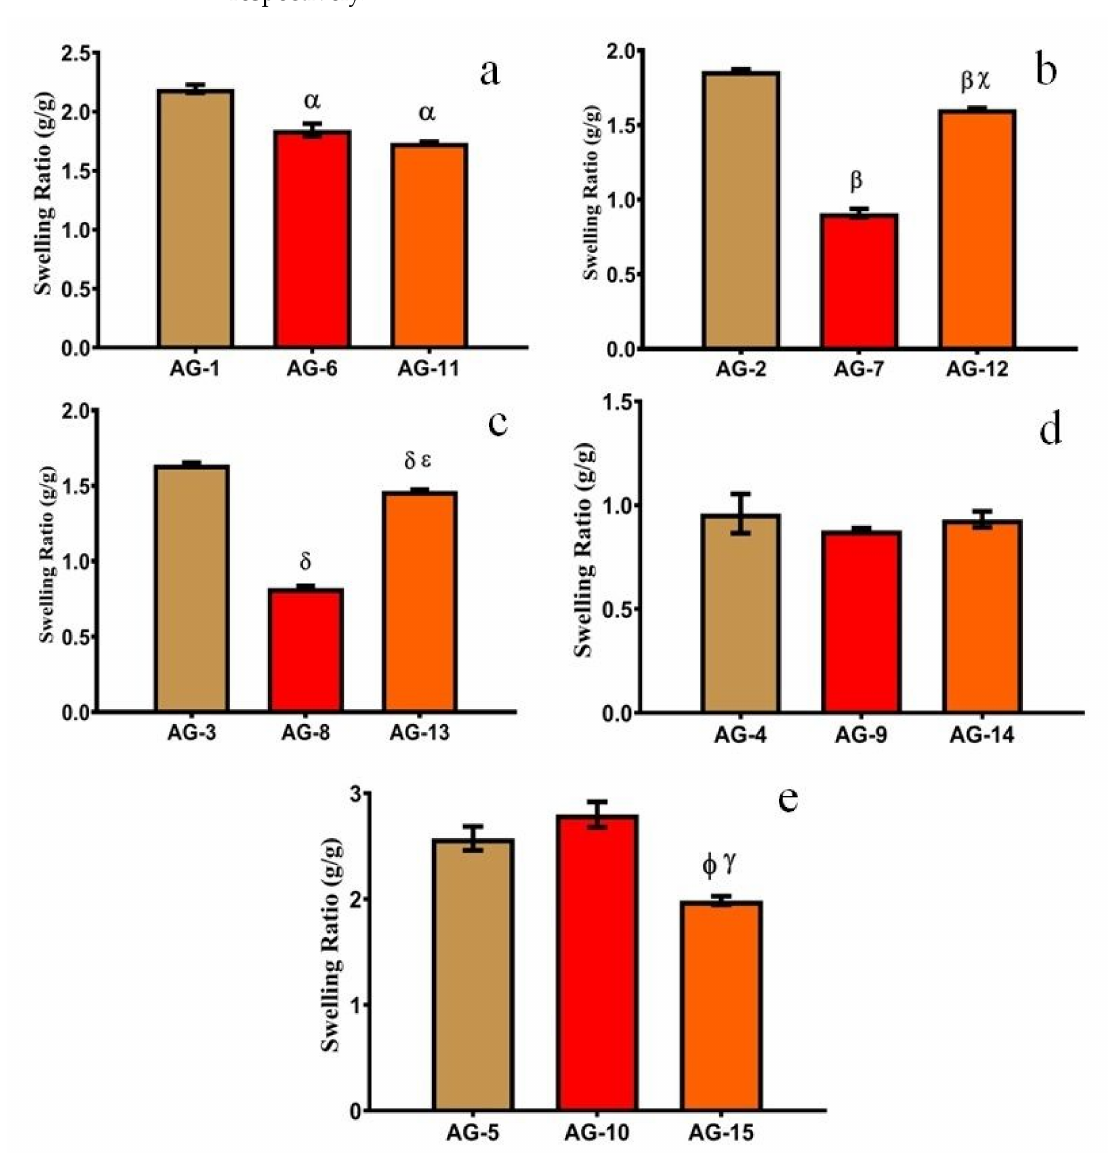
Figure 4. Effect of gelatin on equilibrium SR at pH 1.2 with different AA concentrations, i.e., ( a ) 16.66 g, ( b ) 33.33 g, ( c ) 50 g, ( d ) 66.66 g and ( e ) 83.33 g. All the data are presented as means ± SD ( n = 3). p < 0.05, α compared with AG-1, β compared with AG-2, χ compared with AG-7, δ compared with AG-3, ε compared with AG-8, φ compared with AG-5, γ compared with